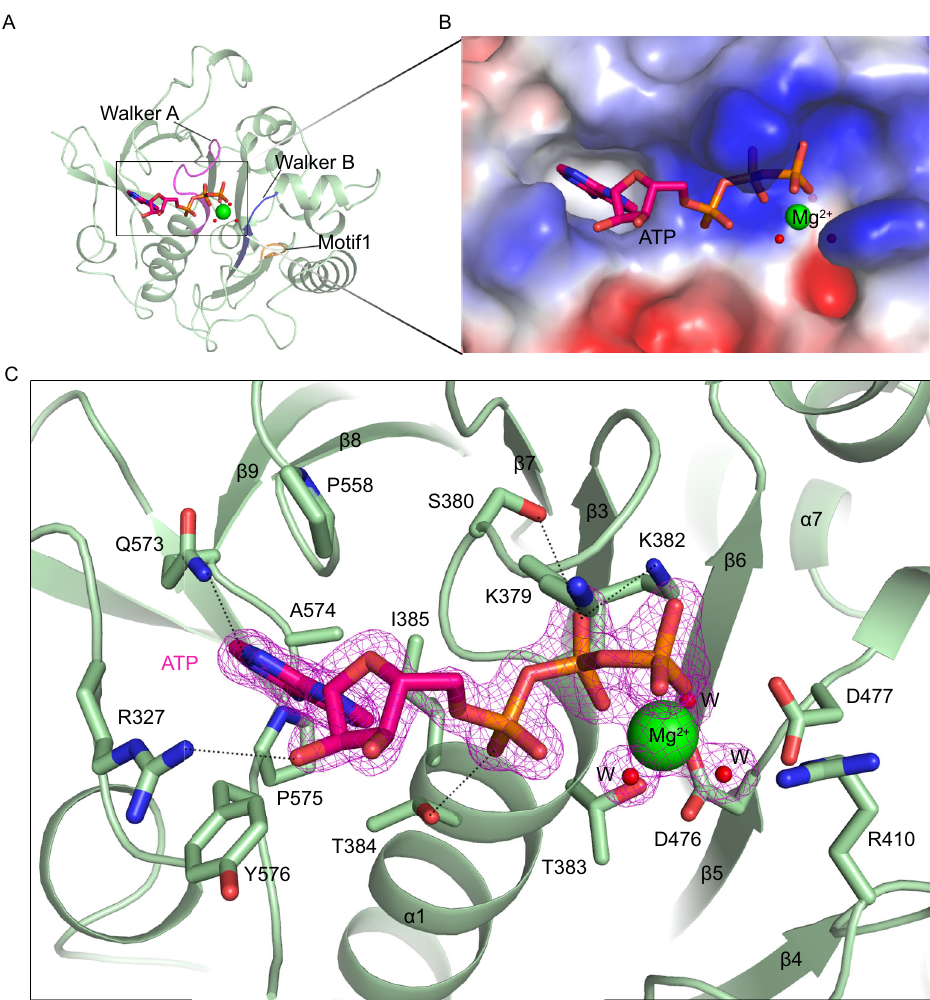
Figure 2. The nucleotide-binding site of Mt EccC-ATPase 3 . (A) The location of the nucleotide-binding site in Mt EccCb1-ATPase 3 . ATP and the magnesium ion, are shown as stick representations and as a sphere, respectively. The Walker A, Walker B and Motif 1 are colored magenta, blue and orange, respectively. (B) Close-up view of the nucleotide-binding pocket shown in electrostatic surface representation. ATP and the magnesium ion, are shown as stick representations and as a sphere, respectively. (C) Interactions between Mg 2+ , ATP and nearby amino acid residues. Green and red spheres represent Mg 2+ and water molecules, respectively. The 2 F o - F c density map (pink mesh) of ATP, Mg 2+ and the coordinated water molecules is contoured at 1 σ . The dashed lines represent hydrogen bonds between ligands and the protein. W, water